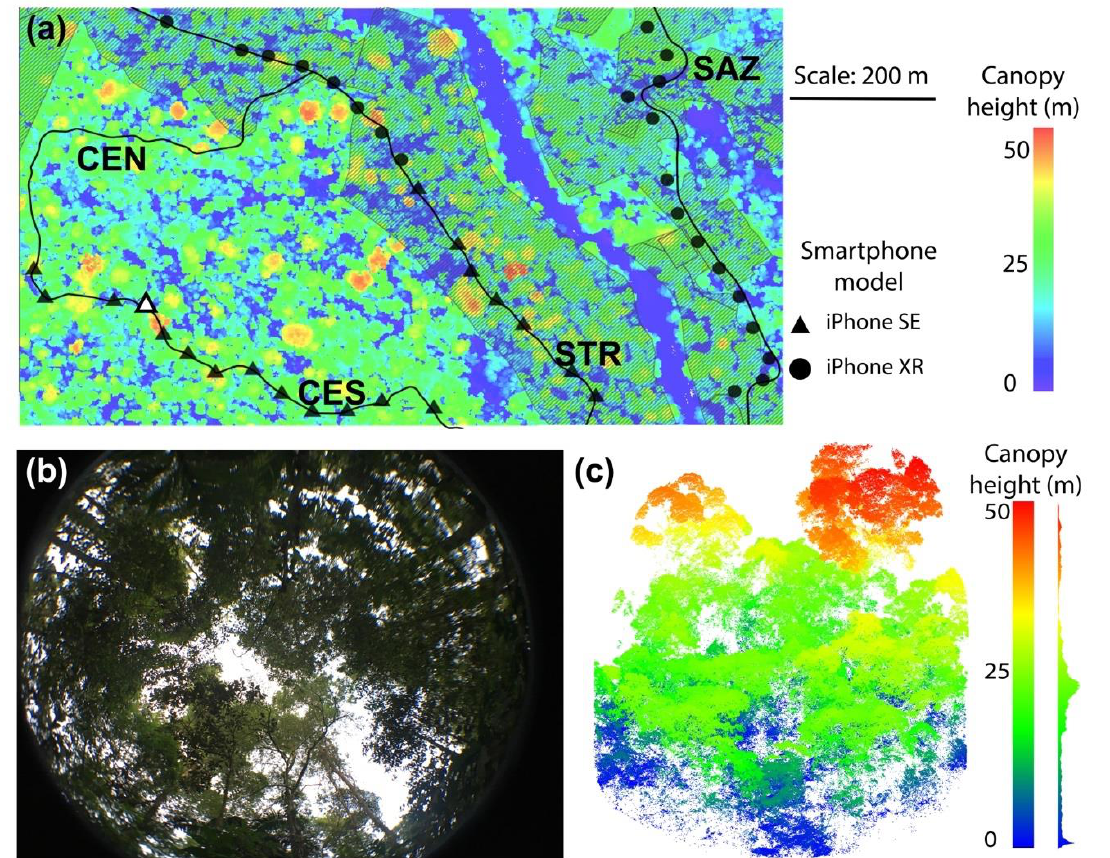
Figure 1. Overview of study area at La Selva, Costa Rica. ( a ) Lidar derived canopy height above ground. Lines show trails through the research reserve and points denote locations where smartphone images were taken. Shaded areas are secondary forests; old growth forests are unshaded. ( b ) Example smartphone fisheye image taken at trail location CES750 (location indicated in ( a ) with white triangle). ( c ) Example lidar point cloud data centered at trail location CES750.